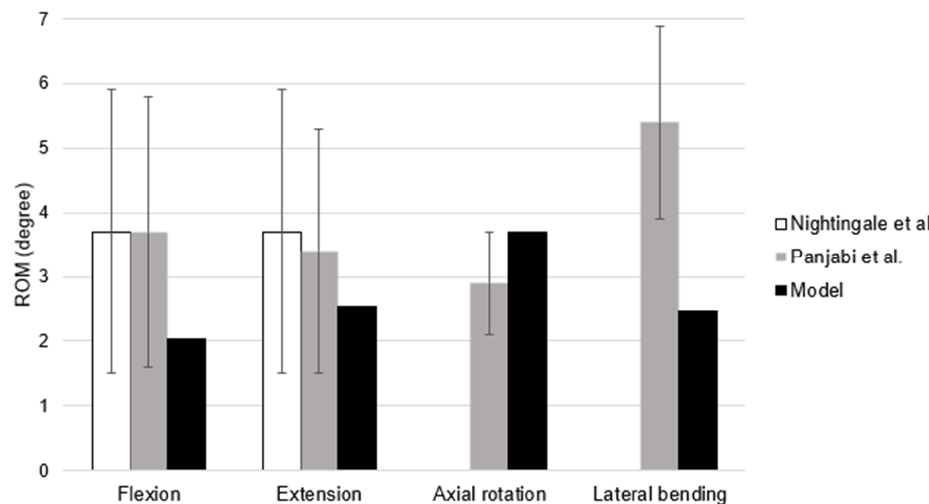
Figure 4. Comparison of the FSU response against experimental data [34,35] for 1 Nm moment in flexion, extension, axial rotation, and lateral bending.